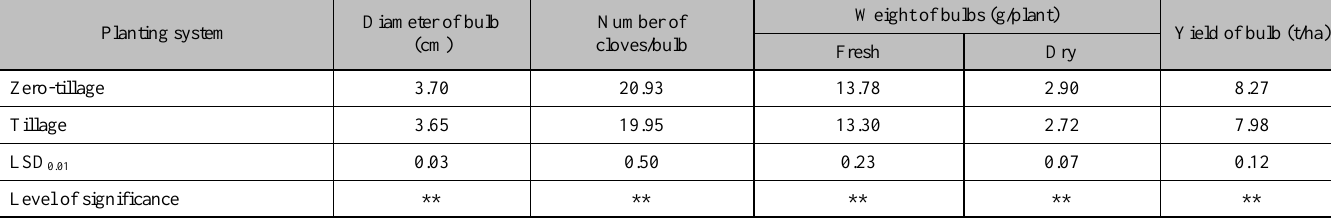
Table 6. Main effects of planting system on diameter of bulb, number of cloves/bulbs, fresh weight, dry weight and yield of bulb.